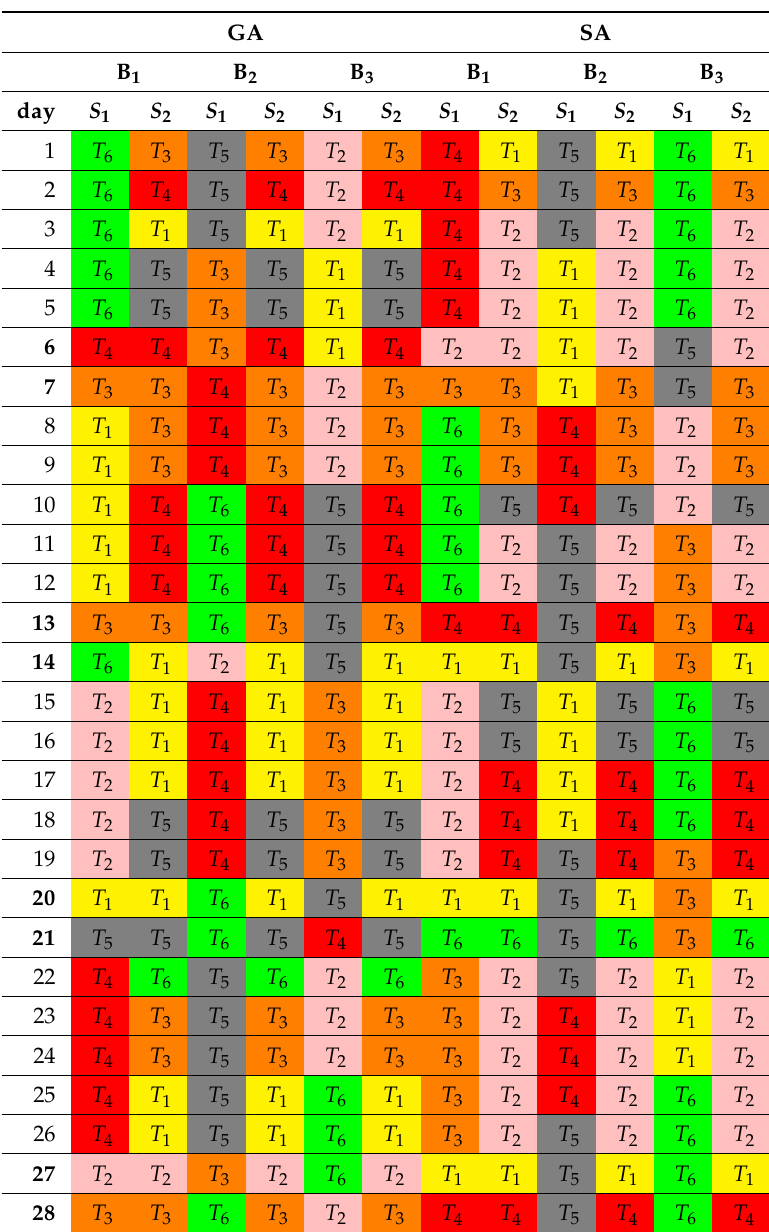
Table 10. GA and SA physician schedule for